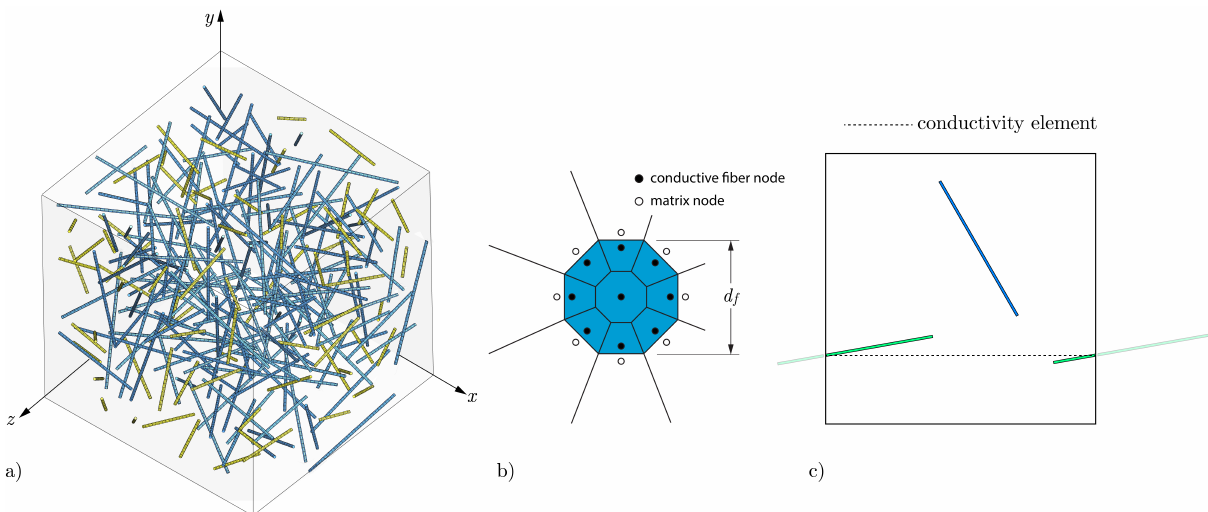
Figure 2. ( a ) Fiber inclusions within unit cell; ( b ) discretization of fiber cross-section; and ( c ) periodic representation of fibers that intersect